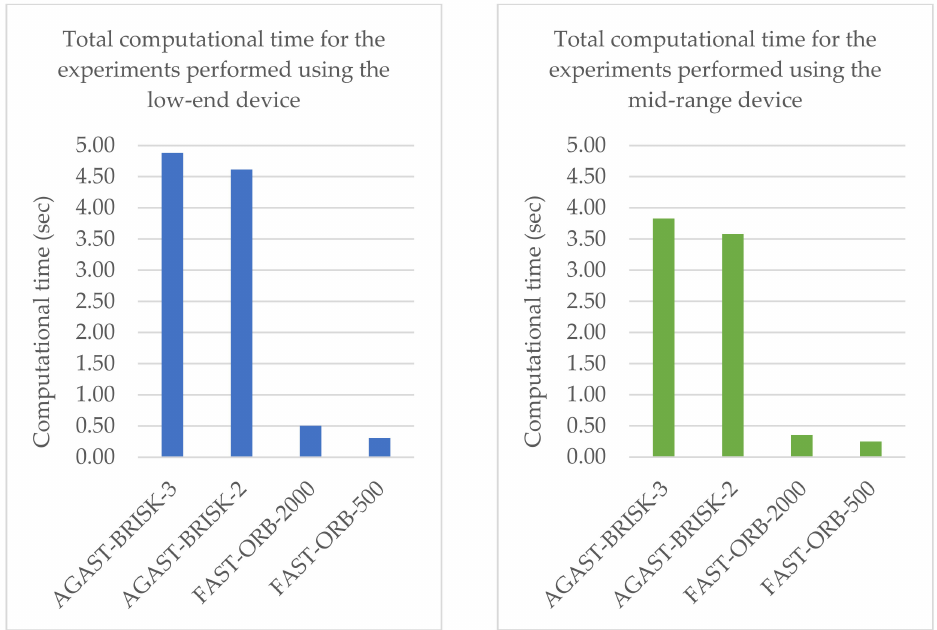
Figure 7. Clustered bar charts illustrating the total computational time required by the four basic steps of the image matching process for each experiment performed via